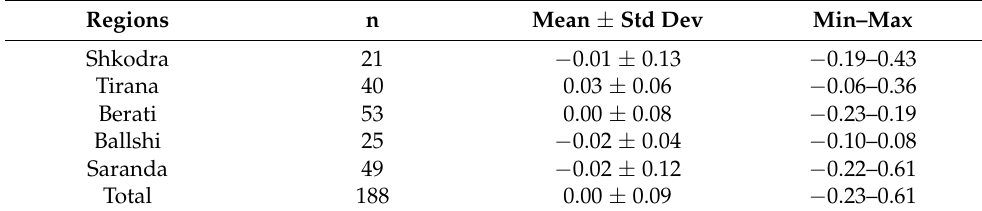
Table 1. Descriptive statistics of the body condition index (CI) of Hermann’s tortoises in five regions of